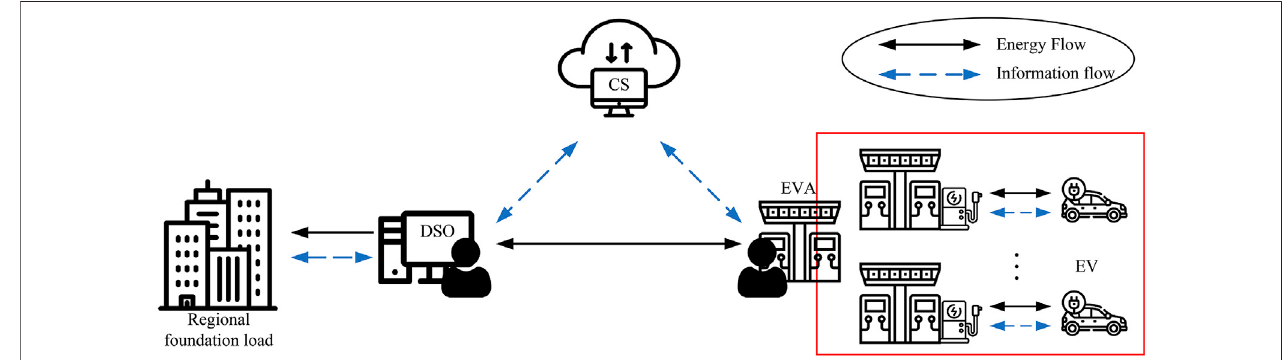
FIGURE 1 | V2G real-time optimal regulation framework.